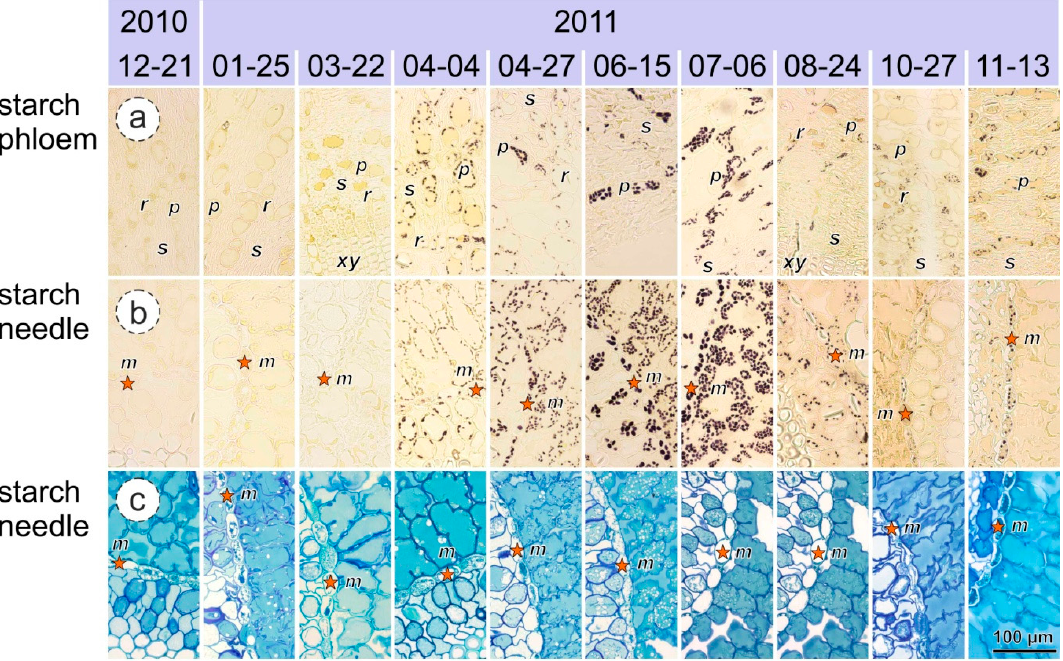
Figure 6. Histochemical detection of starch in secondary phloem and needles. ( a ) Secondary phloem (and parts of sapwood) stained with Lugol´s solution, ( b ) areas next to the needle endodermis stained with Lugol´s solution, and ( c ) areas next to the needle endodermis stained with toluidine blue at different times of the season. m, mesophyll; p, parenchyma cell in the secondary phloem; r, ray cell in the secondary phloem; s, sieve cells; xy, secondary xylem; stars indicate the locations of the endodermis, bar = 100 µm (the bar is representative for all photos). For regions of interest, see Figure 1.